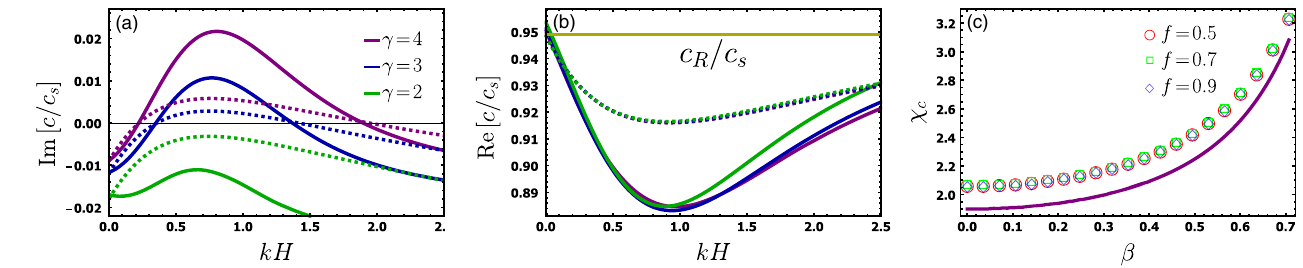
FIG. 4. Linear stability: Simplified analysis. Imaginary (a) and real (b) parts of solutions to the linear stability spectrum in Eq. (10). Here, Im ð c Þ > 0 implies an instability. Note that only one solution branch is discussed (other solution branches exist as well, but they are not discussed here). The solid lines show numerical solutions to Eq. (10), and the dashed lines show the approximate analytic solutions obtained by a linear expansion around c ¼ c according to the legend. (c) The instability threshold χ show direct numerical results, and the solid line is the prediction in Eq.